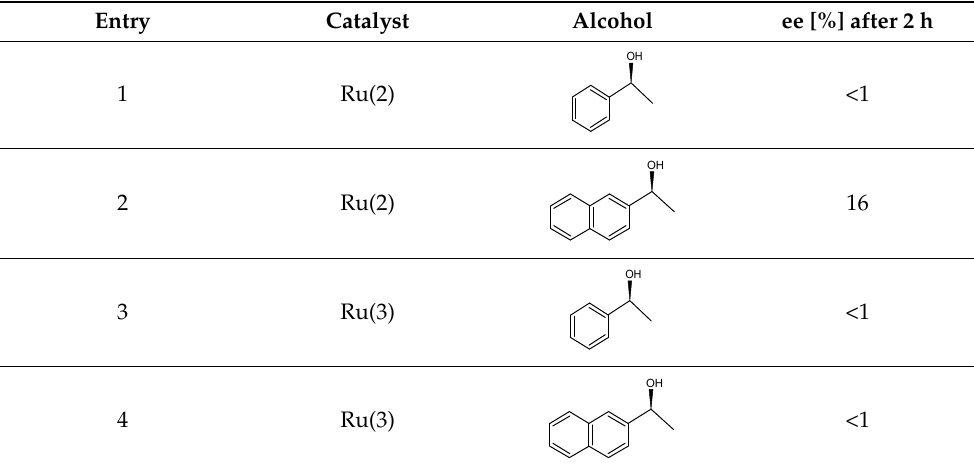
Table 1. Conversion of secondary alcohols with the studied Ru complexes.